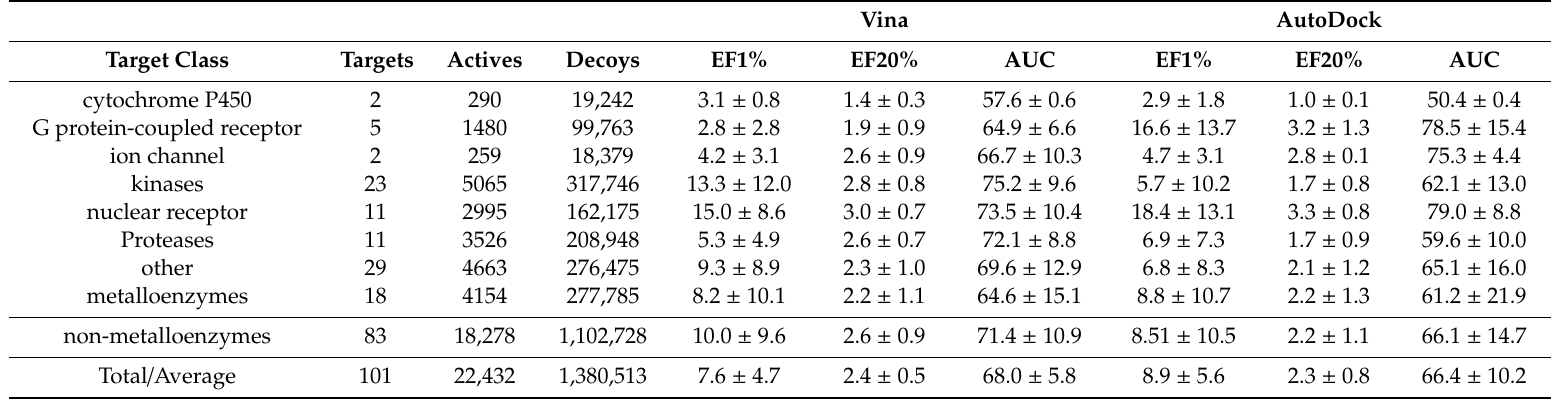
Table 2. Performance of Vina and AutoDock in the discrimination between ligands and decoys for di ff erent classes of